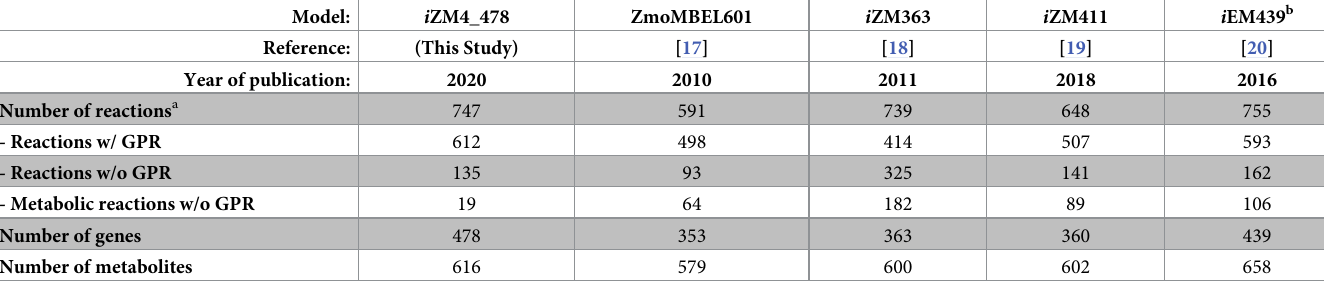
Table 1. Comparison of Z . mobilis genome-scale metabolic